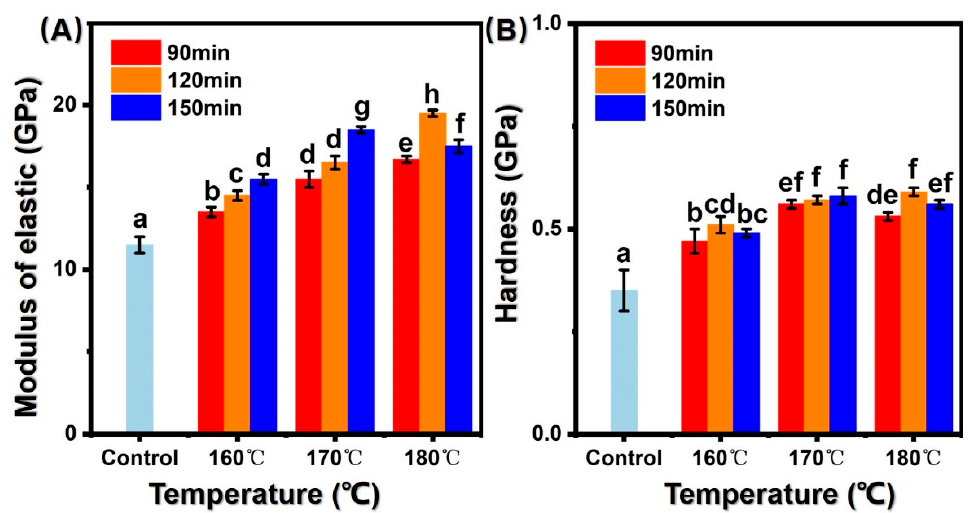
Figure 7. Mechanical properties for the control and treated bamboo cell walls. ( A ) Modulus of elasticity; ( B ) hardness. The different letters represent significant differences between treatments ( p < 0.05).